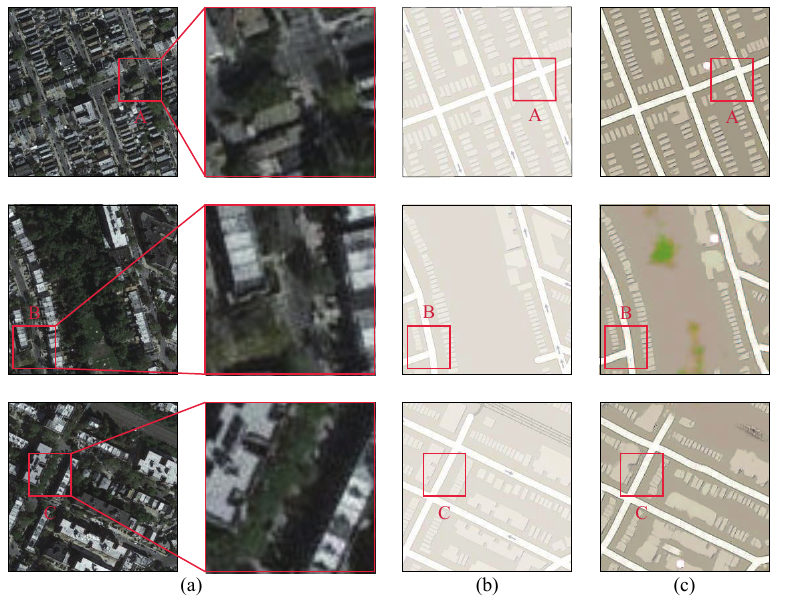
Figure 7. Results of the mapping network: ( a ) remote sensing image and the shelter area by tree; ( b ) GT and ( c ) synthesis images; (A), (B), and (C) are the patches in the same areas.